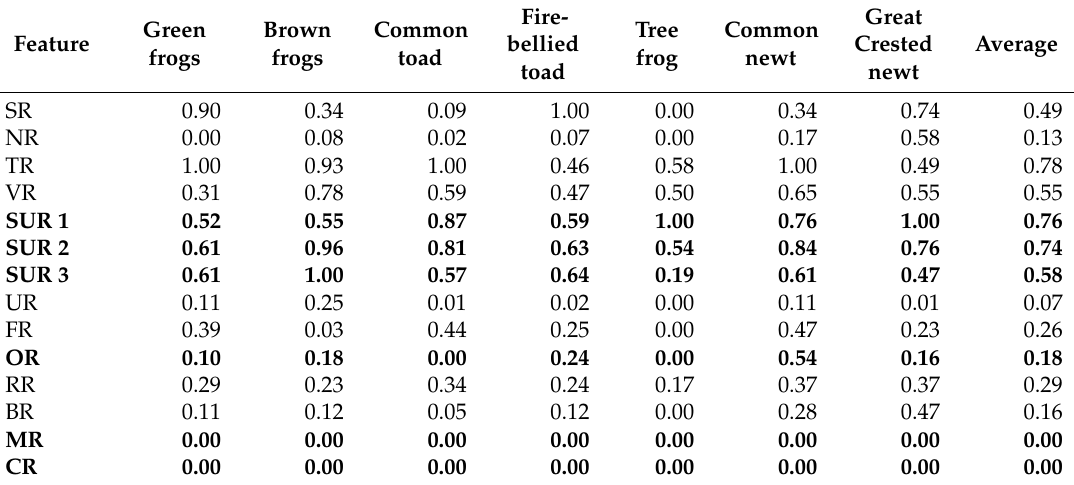
Table 4. Feature importance indicators for each of the amphibian species.